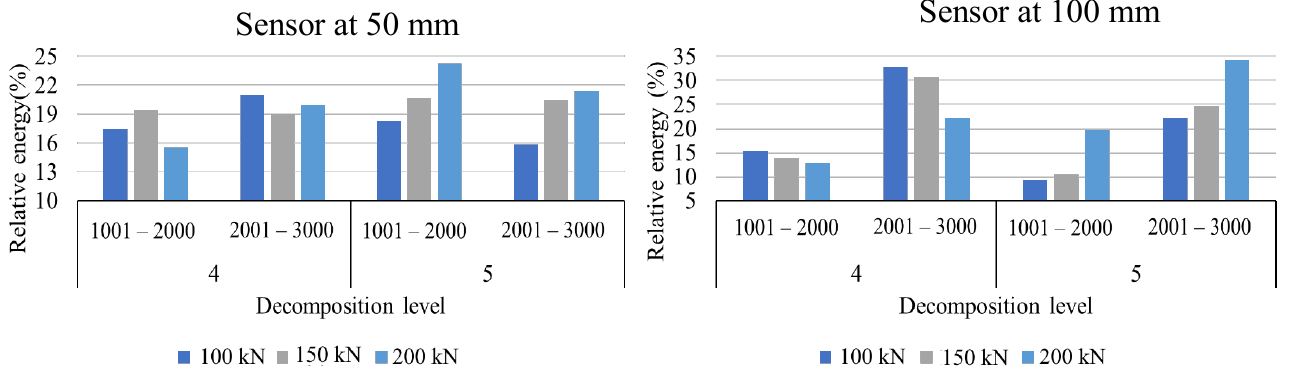
Figure 18. Change in waveform parameters with respect to load (a) Shift in relative energy for 4 and 5 decomposition levels with respect to sample domain.